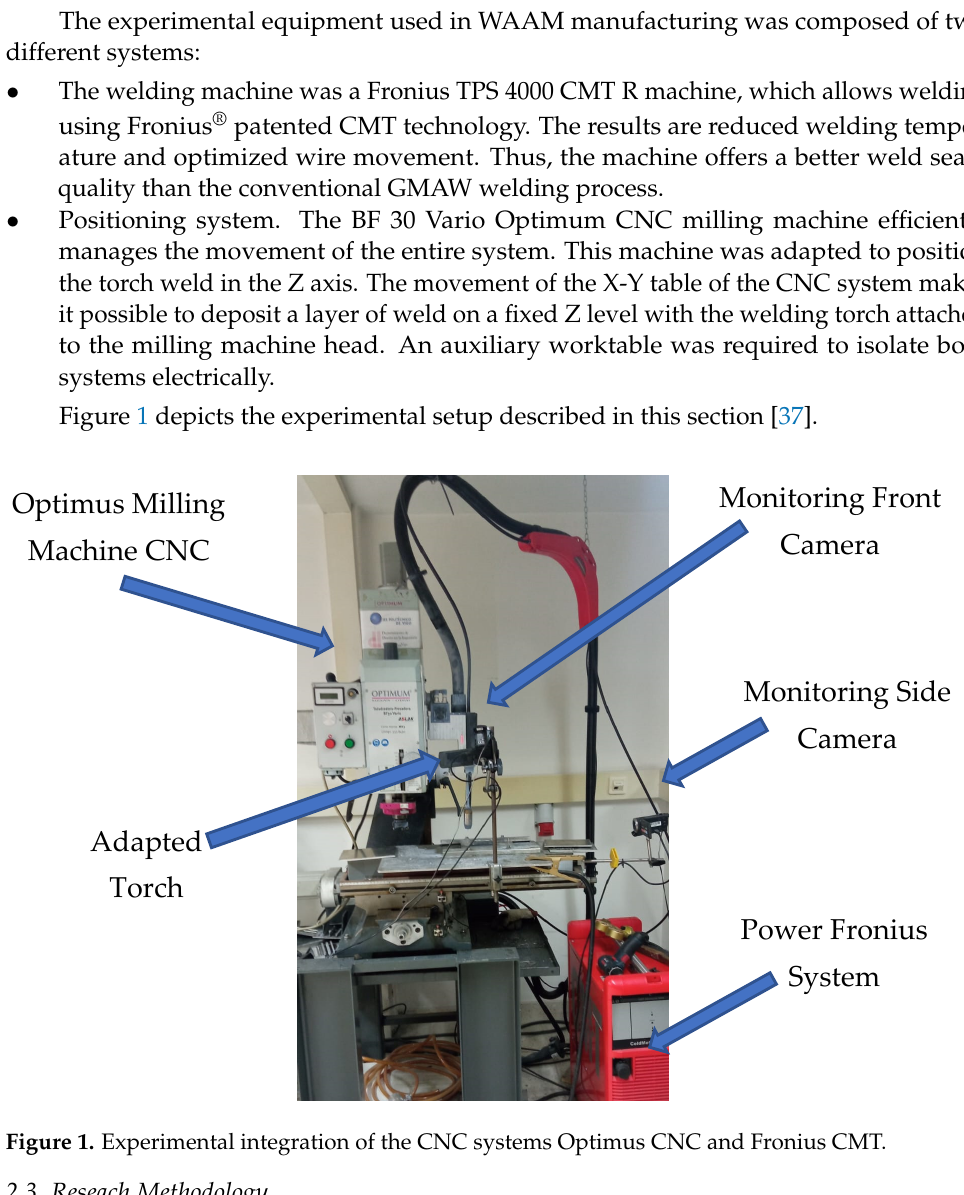
Table 2. Properties of the 5356 aluminum alloy at 25 ◦ C.